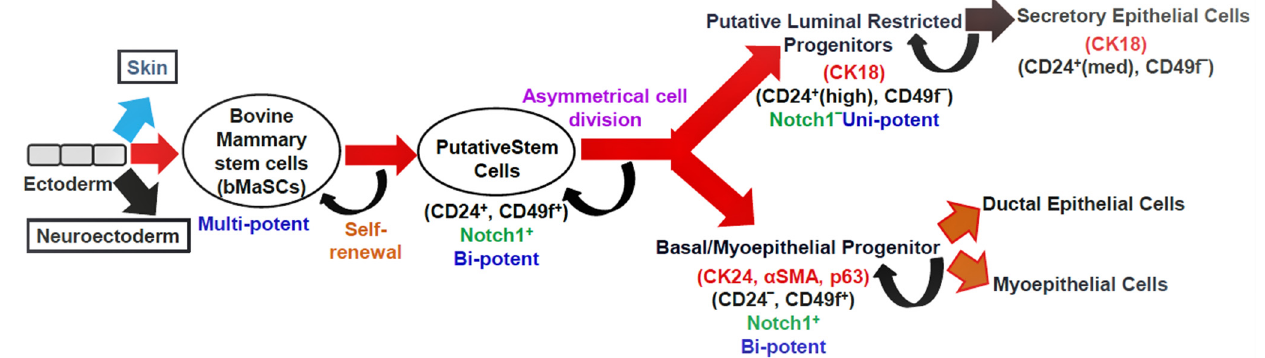
Figure 2. The hypothetical model depicting the mammary epithelial hierarchy in the bovine mammary gland. Cell surface markers: CD24, CD49f; lineage markers: CK18, CK14, α SMA, and p63; CK: cytokeratin, α SMA: smooth muscle alpha-actin, p63: tumor protein p63; med: medium